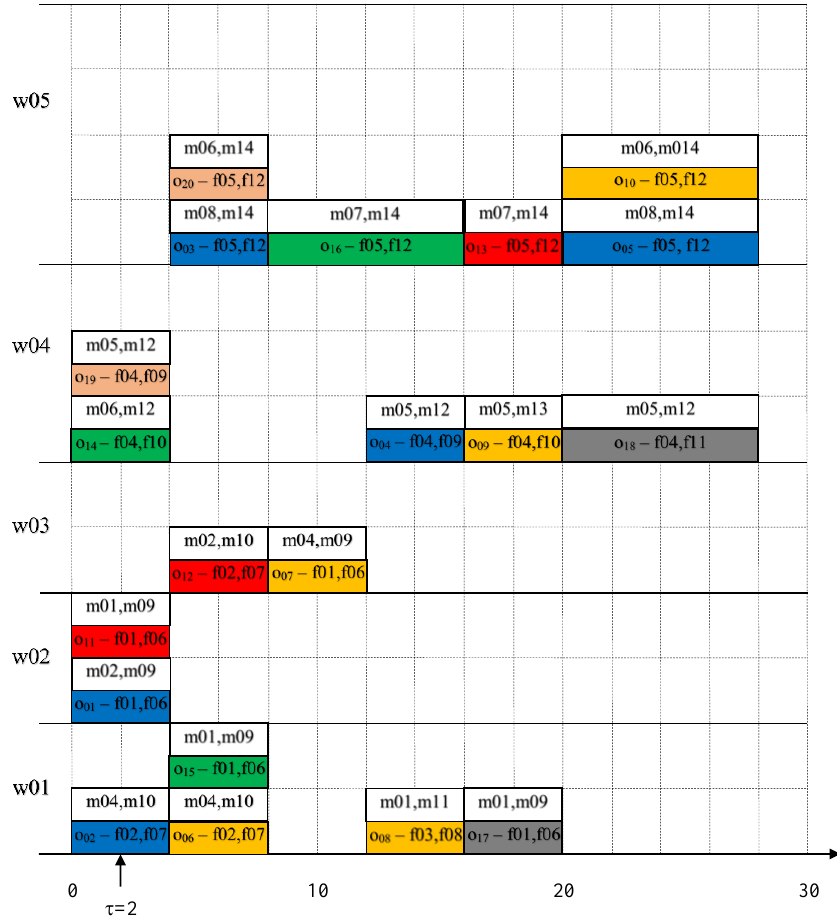
Figure 7. Project implementation schedule with the assignment of tasks and multidimensional resources to workstations for Q_1 (individual projects have different colors as shown in Figure 5).